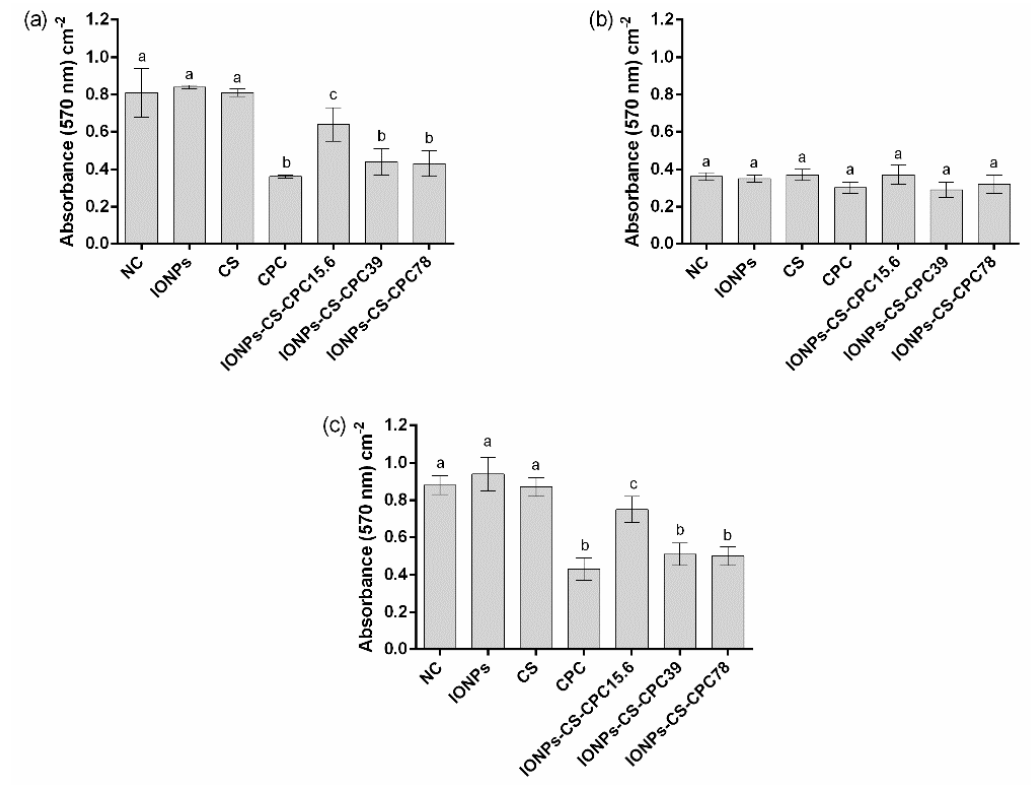
Figure 4. Quantification of total biofilm biomass by crystal violet staining. Mean absorbance values per cm 2 for single biofilms of Candida albicans ATCC 10231 ( a ), Candida glabrata ATCC 90030 ( b ), and dual-species biofilms ( c ) treated with 54.6 µg mL − 1 iron oxide nanoparticles (IONPs), 54.6 µg mL − 1 chitosan (CS), 78 µg mL − 1 cetylpyridinium chloride (CPC) and nanocarrier containing CPC at 15.6 (IONPs-CS-CPC15.6), 39 (IONPs-CS-CPC39) and 78 µg mL − 1 (IONPs-CS-CPC78). Negative control (NC) indicates biofilms treated with pure artificial saliva (without drugs). Error bars represent standard deviations of the means. Different lower case letters indicate significant differences among the groups by one-way ANOVA and Fisher LSD’s test ( p < 0.05).